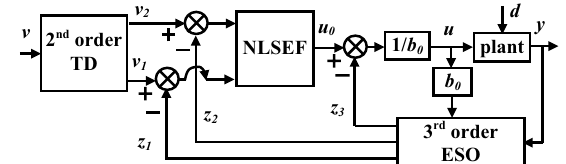
Fig. 5 ADRC schematic diagram for a second order SISO system [82,